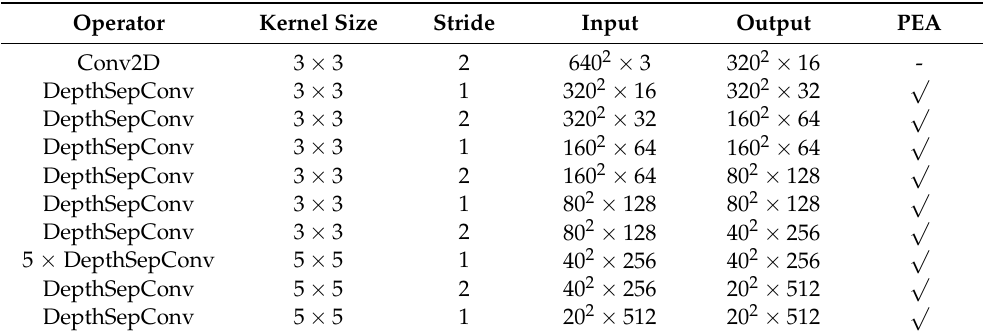
Table 1. The details of NLCNet. PEA = position-enhanced